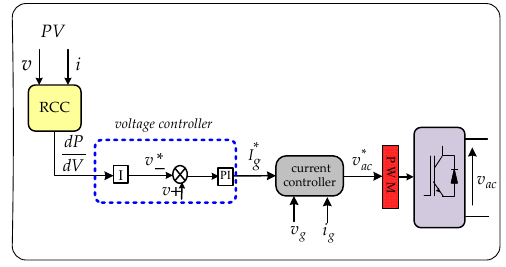
Figure 9. Block diagram of the whole PV control scheme. RCC: ripple correlation